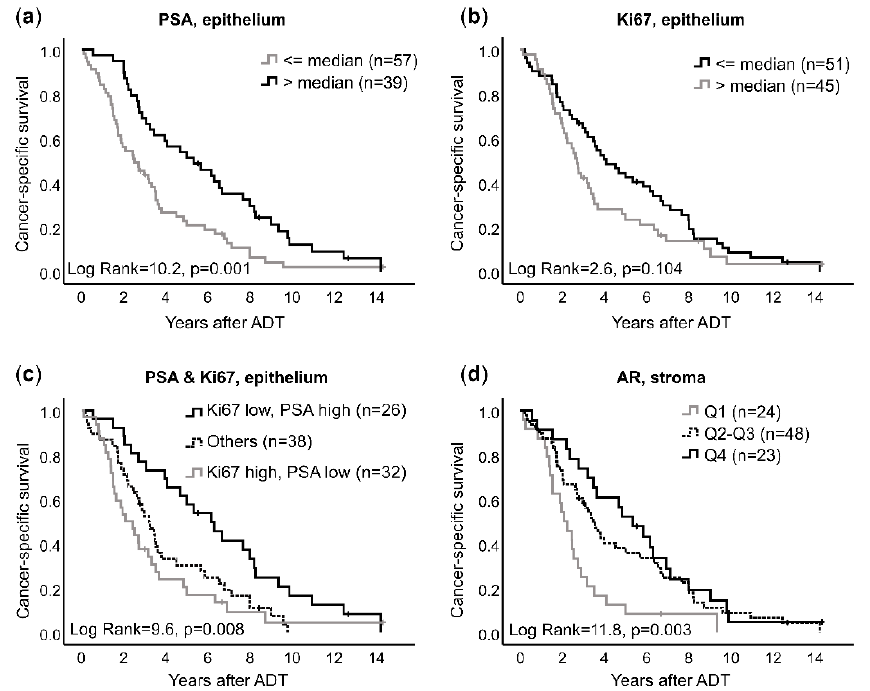
Figure 2. Tumor cell proliferation (Ki67) and expression of prostate-specific antigen (PSA) as well as stromal cell expression of the androgen receptor (AR) in prostate tumor biopsies, in relation to patient survival after treatment with androgen-deprivation therapy (ADT). Tumors ( n = 98) were dichotomized by immunoreactivity scores for ( a ) PSA at the median cut-off level (h-score of 8), ( b ) Ki67 (proliferation) at the median cut-off level (13%), ( c ) A combinatory score using the same cut-off levels as in a and b stratifying tumors into 4 groups; “Ki67 low, PSA high”, “Ki67 high, PSA high”, “Ki67 low, PSA low”, and “Ki67 high, PSA low”, of which the two middle groups were analyzed together as “Others”, and ( d ) AR in stromal cells at quartile levels (Q1 ≤ 10%, Q2–Q3: 10–27%, Q4 > 27%). The dichotomized tumor groups were analyzed in relation to cancer-specific survival after ADT, according to Kaplan-Meier survival analysis. Table 3. Multiple Cox regression analysis of specified immunoreactivity scores in primary tumor biopsies, in relation to cancer-specific survival after androgen-deprivation therapy (ADT). Clinical